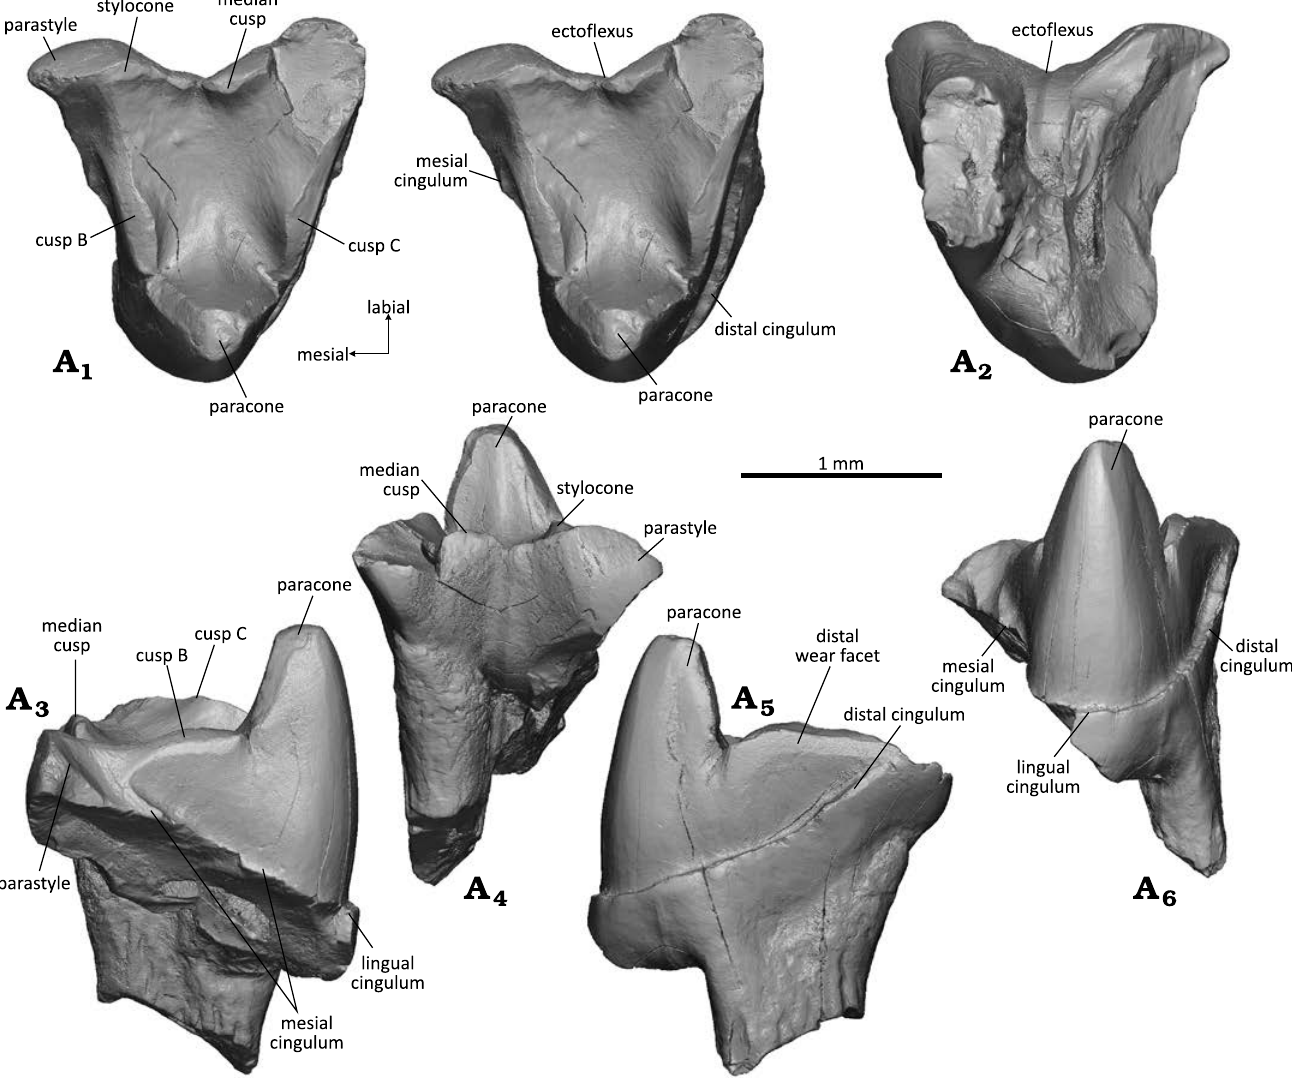
Fig. 3. Spalacotheriid mammal Cifellitherium suderlandicum gen. et sp. nov., WMNM P82308 from Busche Quarry near Balve, North Rhine-Westphalia, Germany, Barremian–Aptian (Lower Cretaceous). Right upper molar in occlusal (stereopair, A 1 ), dorsal (A 2 ), mesial (A 3 ), labial (A 4 ), distal (A 5 ), and lingual (A 6 )